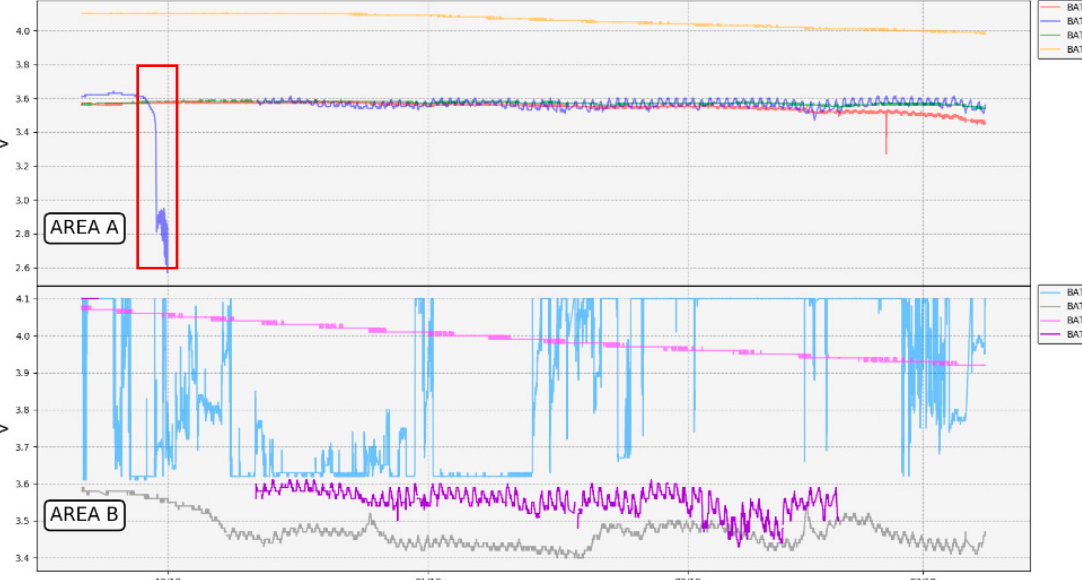
Figure 14. Detail of the temperature record when interruptions in the network operation (grey dashed rectangle) take place due to adverse weather conditions.